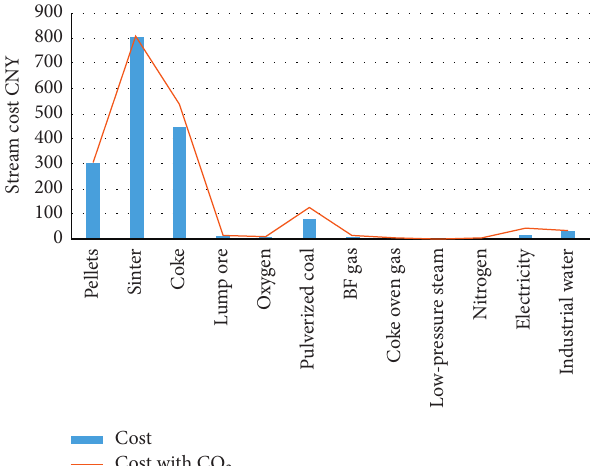
Figure 3: Cost of each stream.